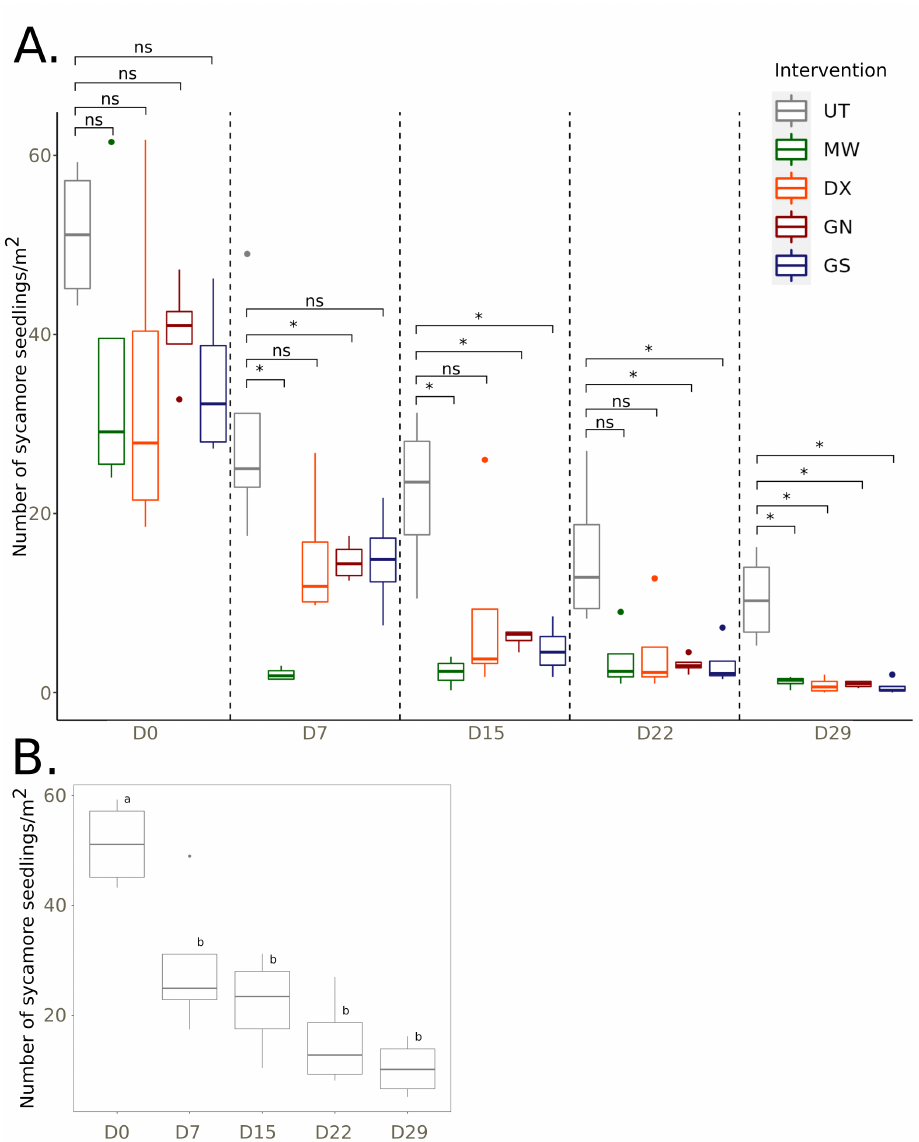
Figure 2. Results of experiment 1: mean number of sycamore seedlings before mowing and herbicide treatments (D0) and every week post intervention. ( A ) The intervention consisted of mowing (MW), Doxstar ® (DX), Genoxone ® (GN), Garlon Super ® (GS), in green, orange, dark red and dark blue, respectively. Untreated condition (UT) is illustrated in grey. Outliers are represented with a dot. Dashed lines separate the different days of seedlings counting; ( B ) mean number of sycamore seedlings over time in the untreated area. Letters indicate results of Tukey test. ns: non-significant; *: p <